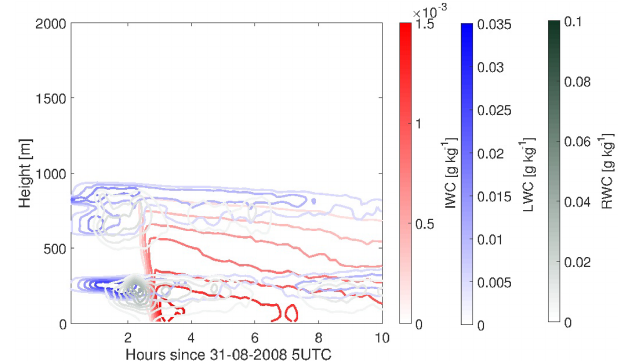
Figure 14. Mean values of LWC (blue), IWC (red), and RWC (green) of the SensCDNC simulation with 2cm − 3